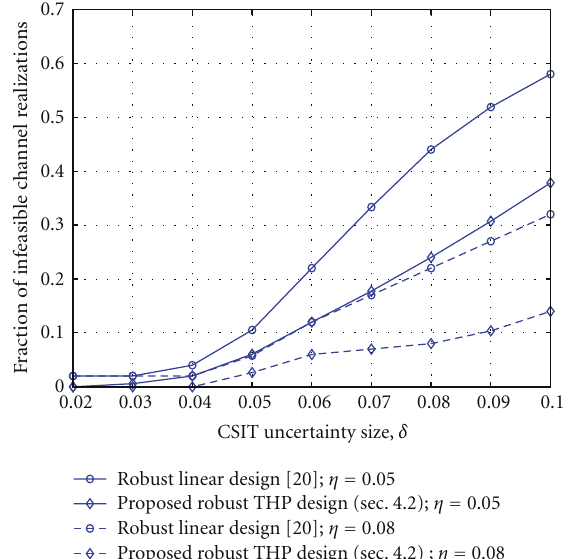
Figure 7: Fraction of infeasible channel realizations for di ff erent values of CSIT uncertainty size δ 1 = δ 2 = δ in the proposed robust design in Section 4.2 for the NBE model. N t = 4, M = 2, N r N L = L = 2, and η = η = η = 0 . 05,0 . 08. Proposed r 2 = 2, 1 2 1 2 robust THP transceiver design in Section 4.2 has lesser infeasible channel realizations than the robust linear design in [20].